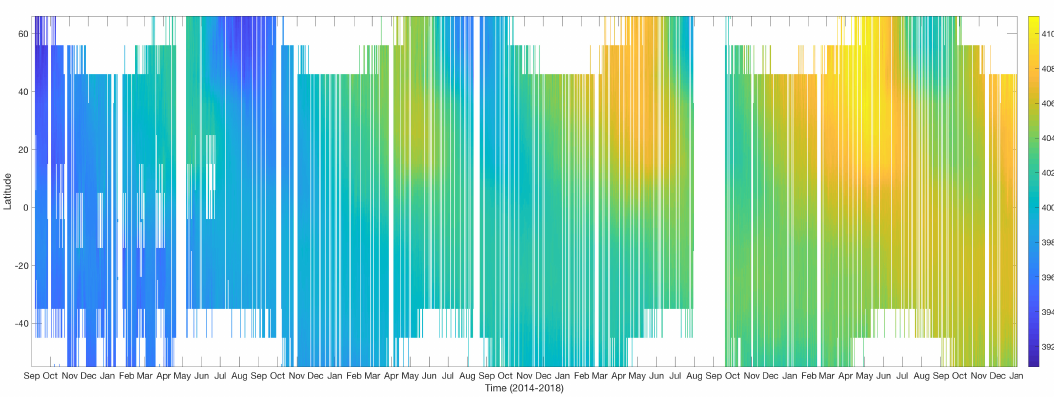
Figure 2. OCO-2 XCO 2 daily background, 2014–2018. Daily medians are calculated for each 10-degree latitude bands and interpolated at 1-degree